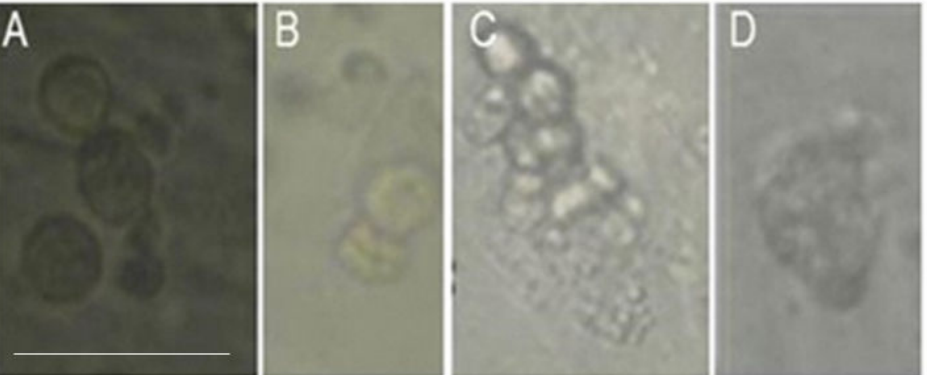
Figure 3. Morphology of developed cells/colonies from isolated cells from testicular biopsies of SCOS patients in-vitro. Germ cells from testicular biopsies without sperm of SCOS patients could form single cells and/or small, medium, and large colonies in MCS culture. ( A )—single cells, ( A , B )—pair cells, ( C )—small colony (contained more than 10 cells and less than 50 cells), and ( D )—medium colony (contained between 50 and 150 cells). Inverted microscope × 40. Scale bar: 100 µ